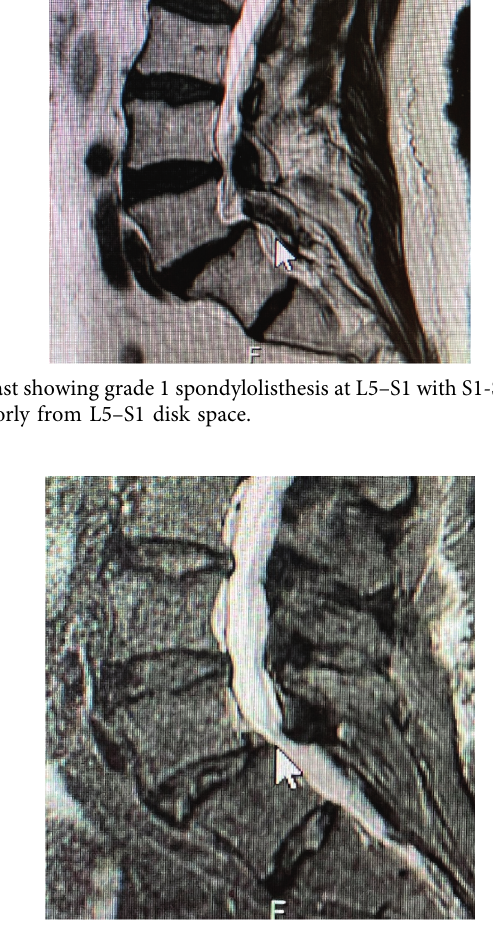
Figure 2: MRI lumbar spine with contrast showing an intradural and enhancing mass in the L5–S1 disc space causing severe stenosis within the intradural space. This object is an intradural enhancing mass causing severe stenosis within the intradural space.